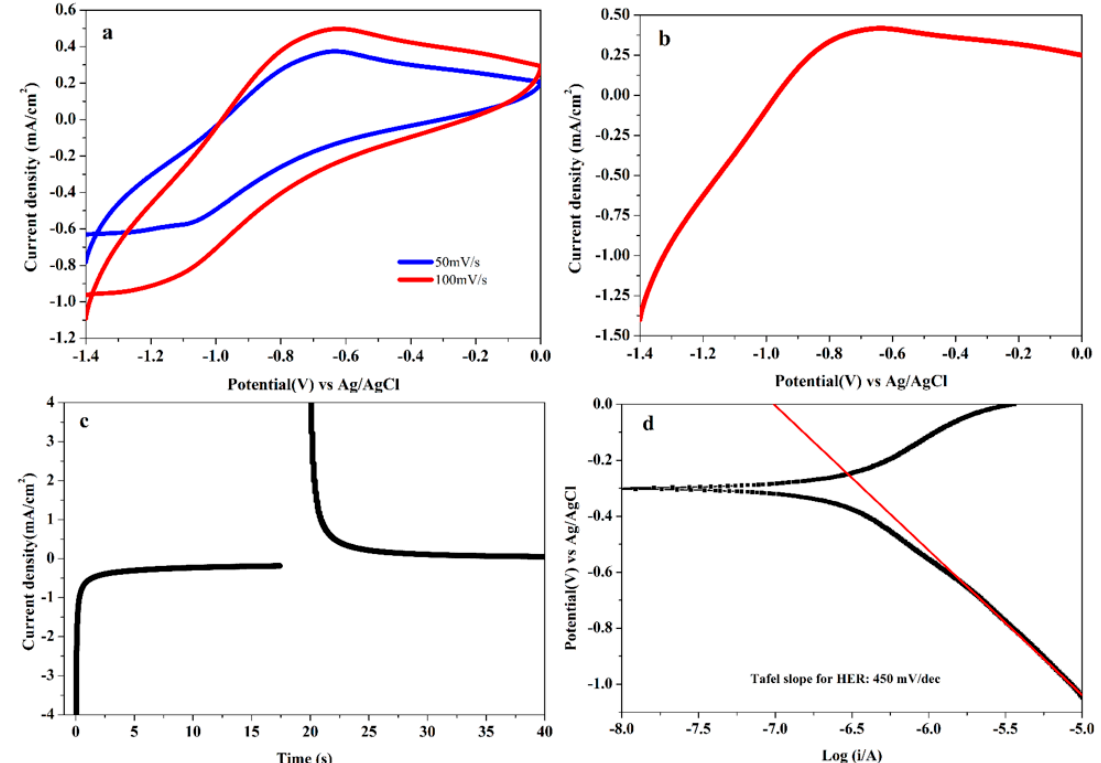
Figure 8. ( a ) Cyclic voltammograms of MIONPs in 0.5 M KOH by applying the potential range from 0 to − 1.4 V vs. Ag / AgCl with a scan rate of 50 mV / s and 100 mV / s; ( b ) Linear sweep voltammetry for MIONPs at 100 mV / s; ( c ) Chronoamperometric (CA) studies of MIONPs on glassy carbon electrode at − 1.4 V; and ( d ) Tafel plot at 10 mV / s for H 2 generation.